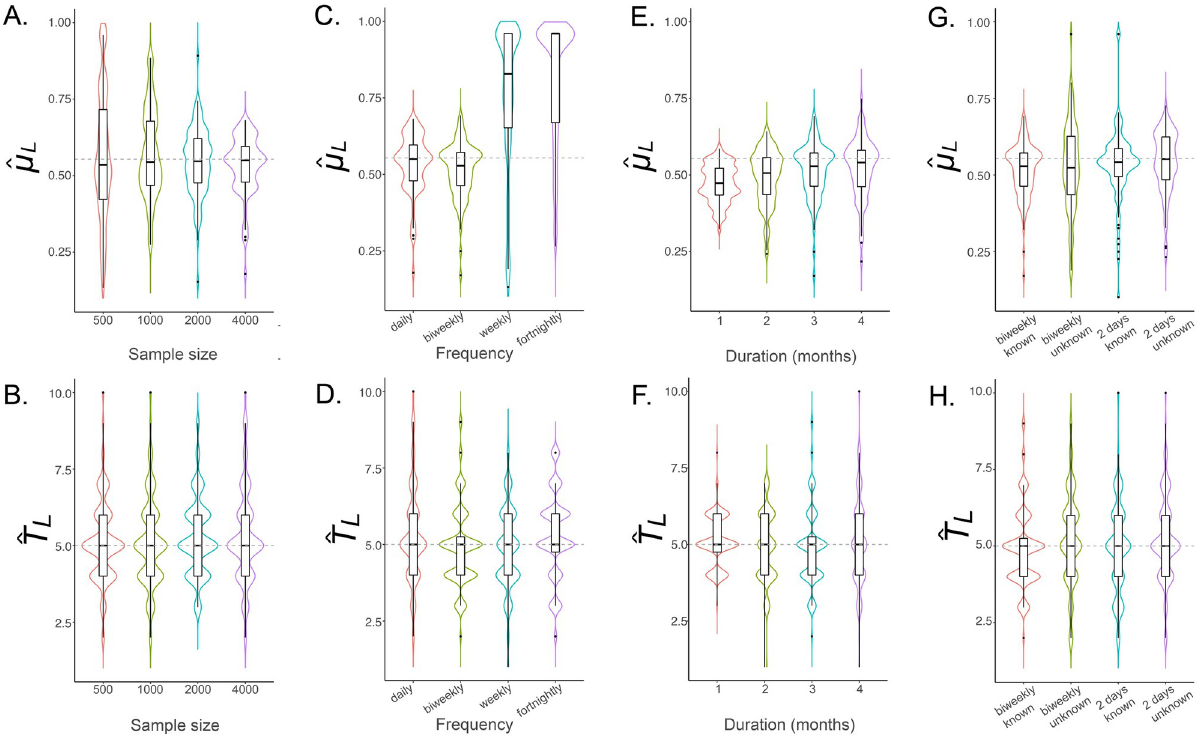
Fig 7. Sampling schemes to estimate μ L and T L for Ae. aegypti . Violin plots depict estimates of μ L and T L for sampling scenarios described in §3.2. The simulated population consists of 3,000 adult Ae. aegypti with bionomic parameters listed in Table 1. Boxes depict median and interquartile ranges of 100 simulation-and-analysis replicates for each scenario, thin lines represent 5% and 95% quantiles, points represent outliers, and kernel density plots are superimposed. The default sampling scheme consists of 1,000 adult females and supplemental larvae sampled daily over a three month period. In panels (A-B) , total larval sample sizes of 500, 1,000, 2,000 and 4,000 are explored. In panels (C-D) , a larval sample size of 4,000 is adopted, and four sampling frequencies are considered—daily, biweekly, weekly and fortnightly. In panels (E-F) , biweekly sampling is adopted, and sampling durations of 1–4 months are explored. The optimal sampling scheme consists of 4,000 larvae and 1,000 adult females collected biweekly over a three month period. In panels (G-H) , the optimal sampling scheme is adopted and cases of biweekly sampling and sampling every two days are compared, both where the sampling day is known and where the sampling day is only known within the interval between